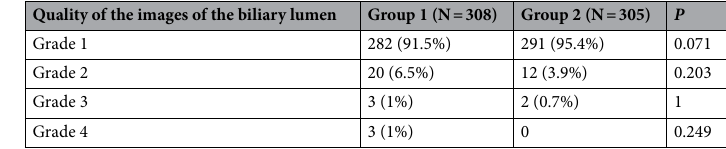
Table 5. Quality of images acquired after ingestion of the fruit